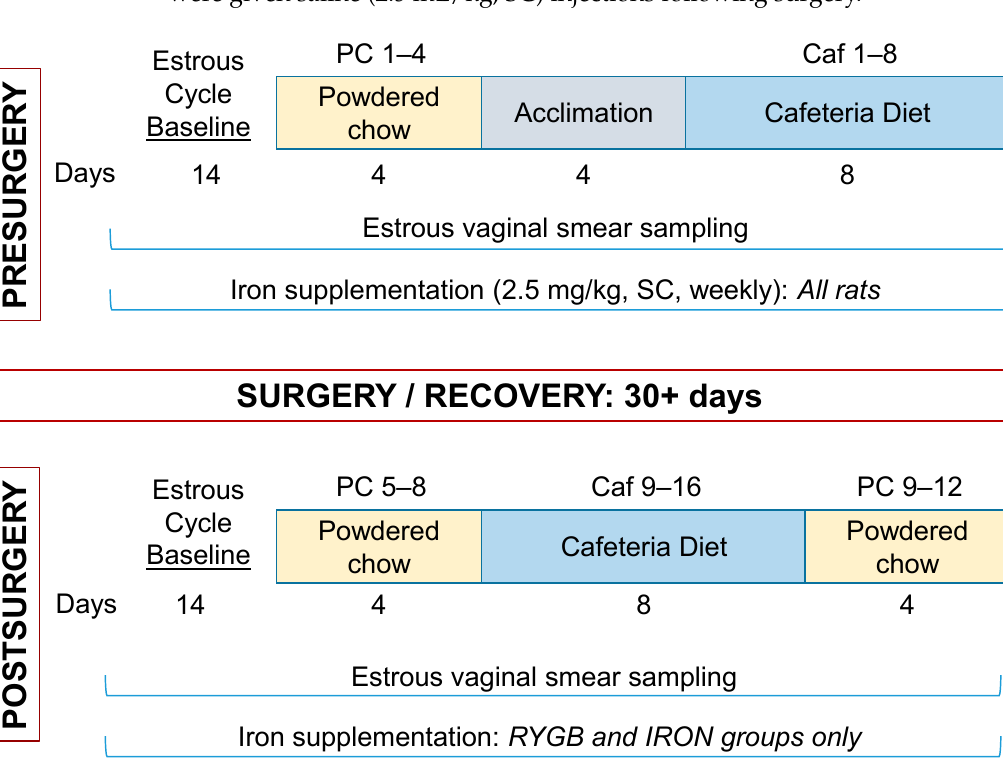
Figure 2. Experimental schedule.